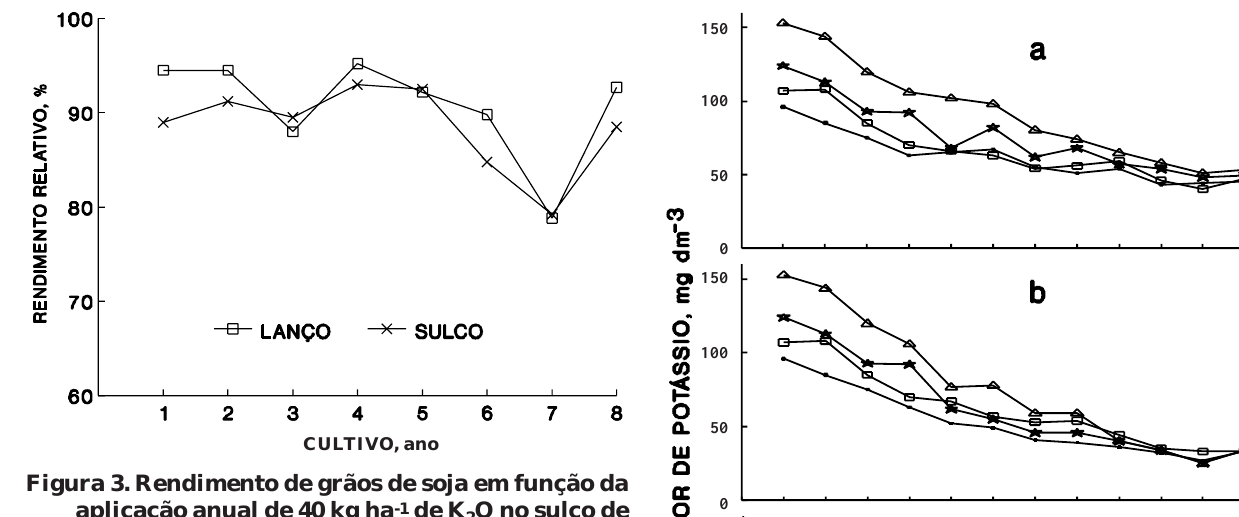
K - 1 o ANO, kg ha -1